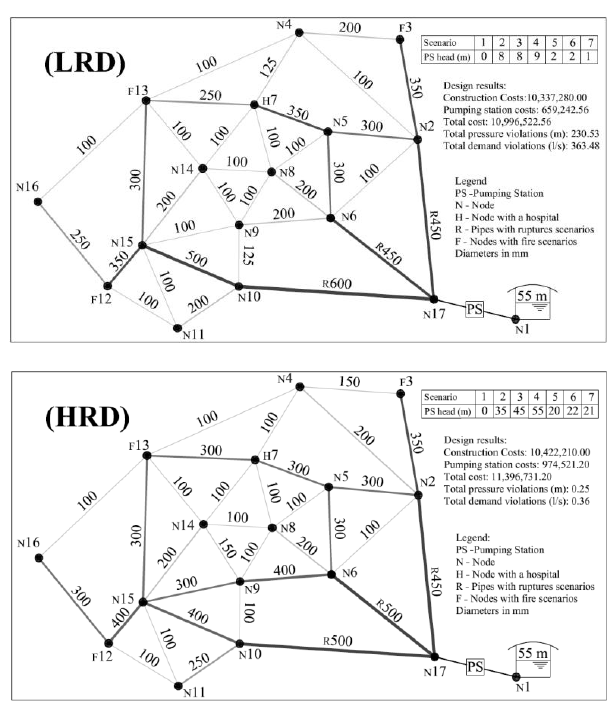
Figure 3. Designs for case study 2: (LRD) low robustness and (HRD) high robustness.